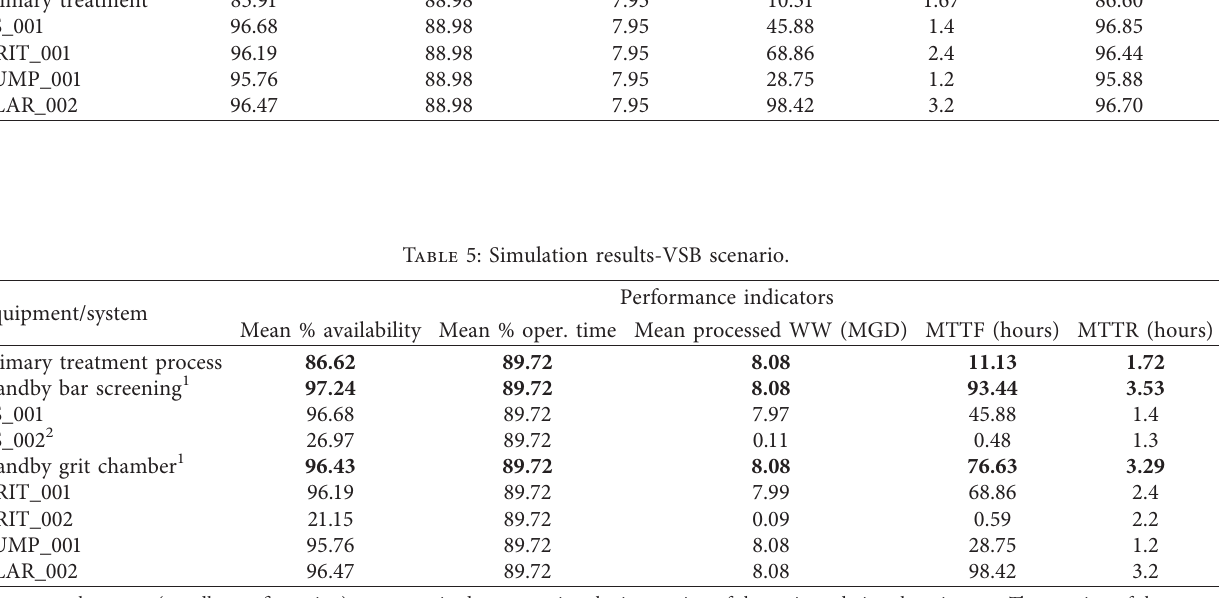
Table 4: Simulation results-immediate effect scenario and comparison with